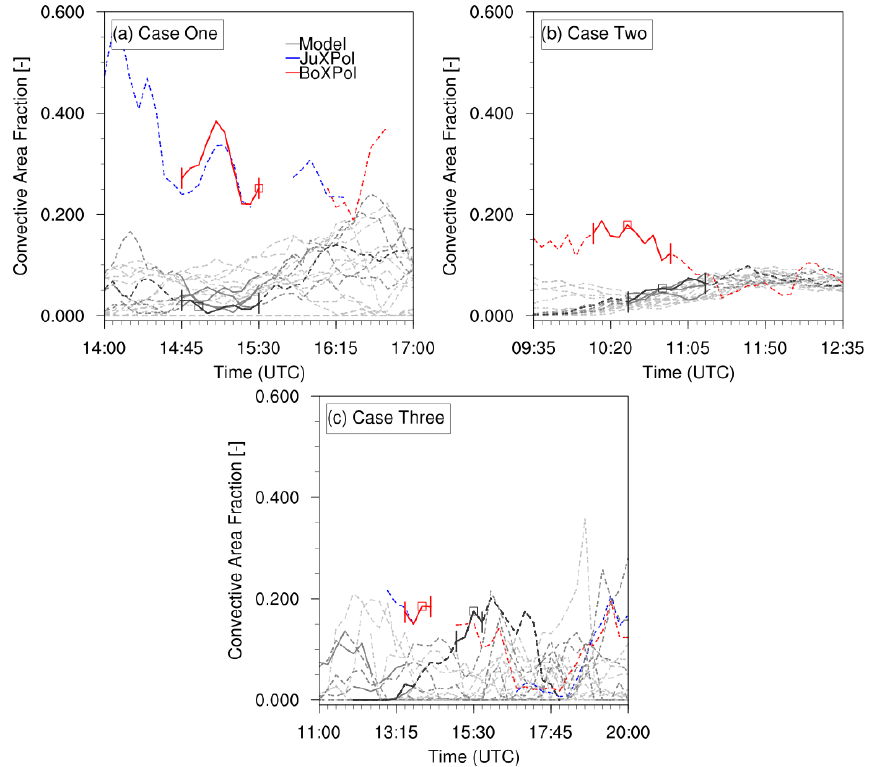
Figure 4. Convective area fraction (CAF) of model ensemble members and observations for the three different case studies. The two vertical bars define the time period used to compute CFADs for observation (red colour) and model (grey colour) with selected ensemble members (solid lines within this extent). The ensemble member with solid black line is used for polarimetric signature comparison. The square marker (red and grey) represents the snapshot used for polarimetric comparison between observation and model for each case study. The observations from BoXPol or JuXPol are shown upon coverage and data availability. The gaps in the radar data represent times, when the polarimetric signatures are strongly attenuated or if the storm extent is only partially covered by the